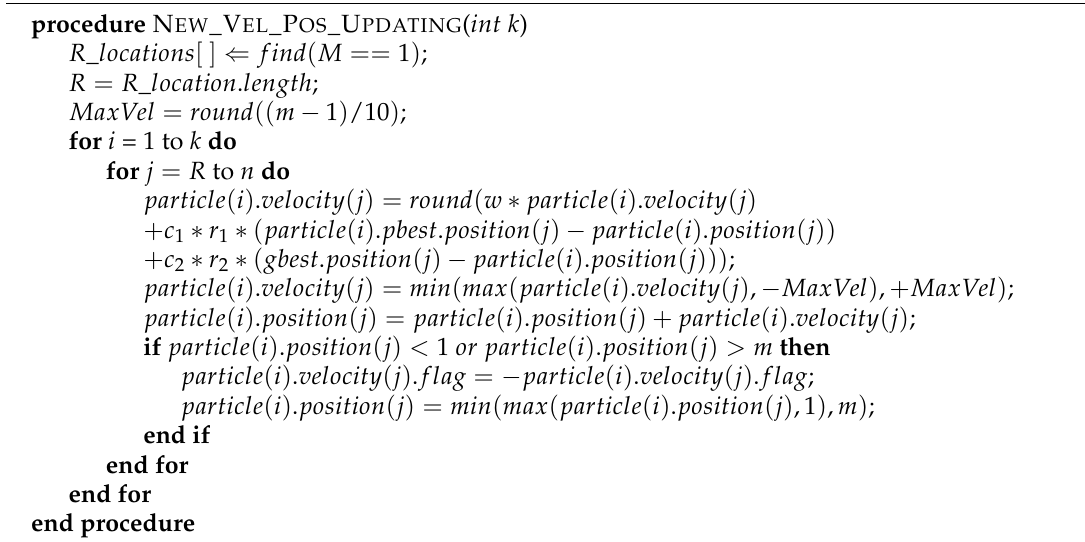
Algorithm A5 Pseudocode of velocity and position updating with reserved